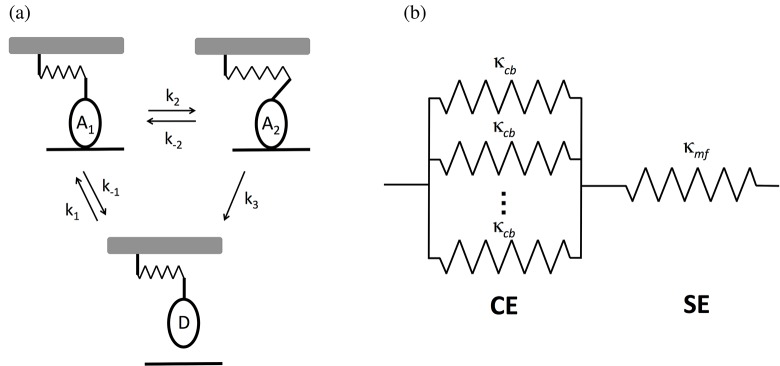
Model of the half-sarcomere.(a) Individual cross-bridges are linearly elastic elements that pass through three states: two attached states (A1 and A2) and a detached state (D). The transition from A2 to D is irreversible, and the transition from A1 to A2 corresponds to the powerstroke. (b) Model of the half-sarcomere. The half-sarcomere was modeled as a cross-bridge element (CE), consisting of cross-bridges attached in parallel, which is in series with the series element (SE), which represents the myofilament compliance.